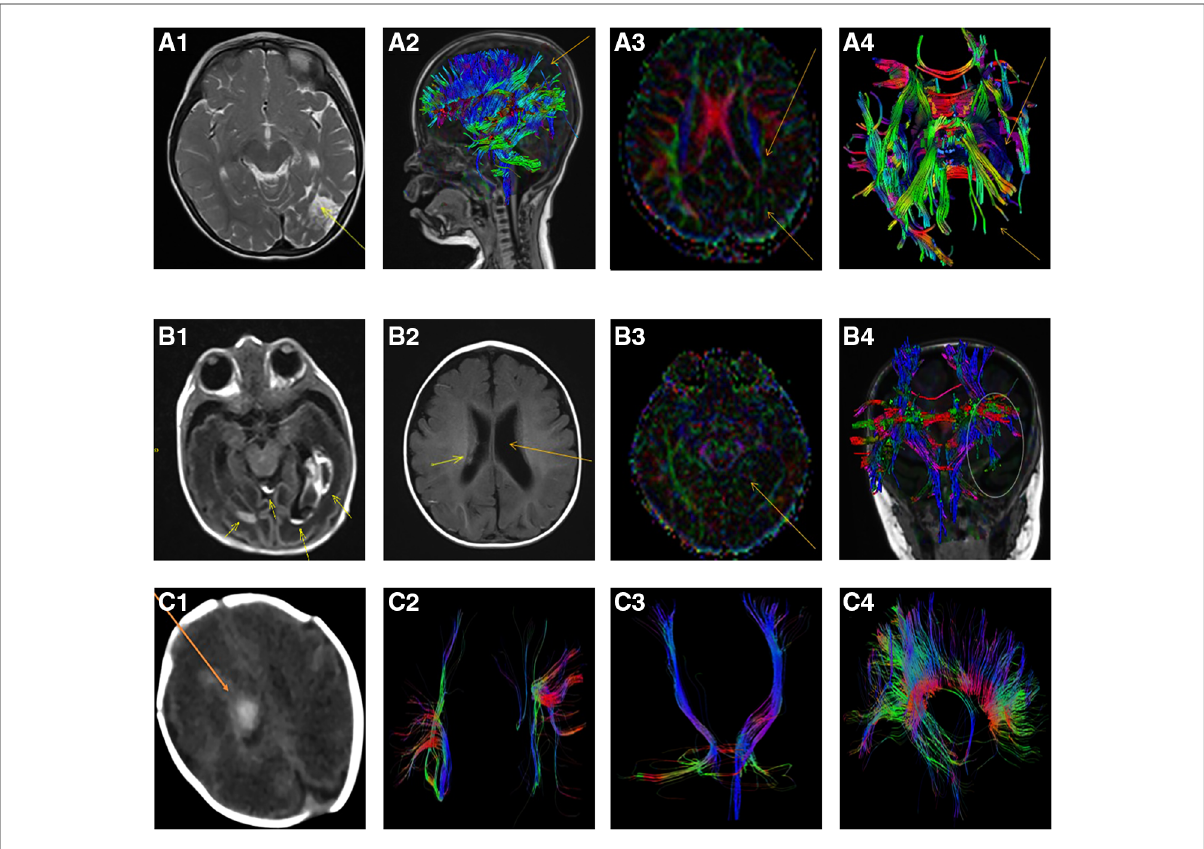
FIGURE 1 Representative lesions and the losses of nerve fi ber bundles from MRI scan and DKI tractography in extremely preterm infants with severe intraventricular hemorrhage. (A1-A4) : The loss of nerve fi ber bundles in DKI tractography at 36 months after intraventricular hemorrhage of an extremely preterm infants with a gestation age of 27 weeks. (A1) : Axial T2-weighted image showed hyperintense in the left temporal and occipital lobes which indicated the formation of softening lesions (arrow); (A2) : Sagittal view, DKI tractography showed the loss of nerve fi ber bundles in parietal and occipital lobes (arrow); (A3) : The decrease and loss of signals of fractional anisotropy (FA) in left hemisphere with DKI scan, especially in the left temporal and occipital lobes (arrow); (A4) : Axial DKI tractography showed the loss of nerve fi ber bundles in the left temporal and occipital lobes (arrow); (B1-B4) : An extremely preterm infants with a gestation age of 27 weeks. (B1) : Axial T1-weighted image showed intraventricular hemorrhage and germinal matrix hemorrhage at birth (arrow); (B2) : Axial T1-weighted image showed reduced hemorrhagic lesion in the right lateral ventricle and post-hemorrhagic ventricular dilatation of the left lateral ventricle at 6 months old (arrow); (B3) : The differential signals of FA between the left and right hemisphere with DKI scan at 6 months old (arrow); (B4) : Coronal DKI tractography showed the breakage and loss of nerve fi ber bundles in posterior horn of the left lateral ventricle (ellipse); (C1-C4) : An extremely preterm infants with a gestation age of 28 weeks. (C1) : CT scan showed intraventricular hemorrhage at 12 days after birth (arrow); (C2) : DKI tractography showed the right superior longitudinal fasciculus (SLF) became thin and sparse compared with the left SLF at 1 year of corrected age; (C3) : DKI tractography showed the right corticospinal tract (CST) became thin and sparse compared with the left CST at 1 year of corrected age; (C4)